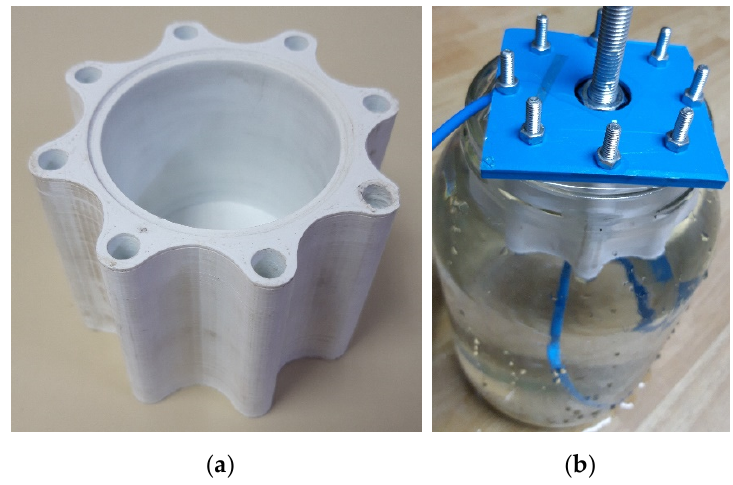
Figure 5. ( a ) The new cylinder body; ( b ) The submerged assembly in the water container—no leaking was found.